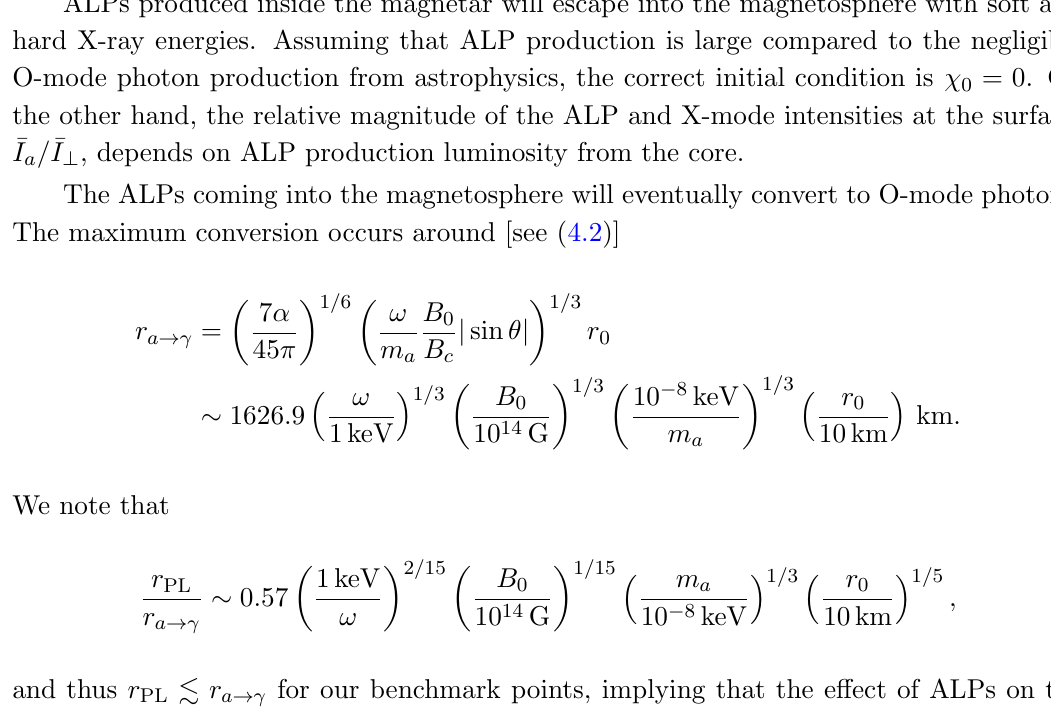
10 14 G and (cid:18) = (cid:25)= 2 in the plane ((cid:22) I k = (cid:22) I ? ; (cid:22) I a = (cid:22) I ? ) at the (cid:2) 1 : 2 10 (cid:0) 3 ) while the right (cid:24) (cid:2) 9 : 4 10 (cid:0) 5 (cid:24) (cid:2)